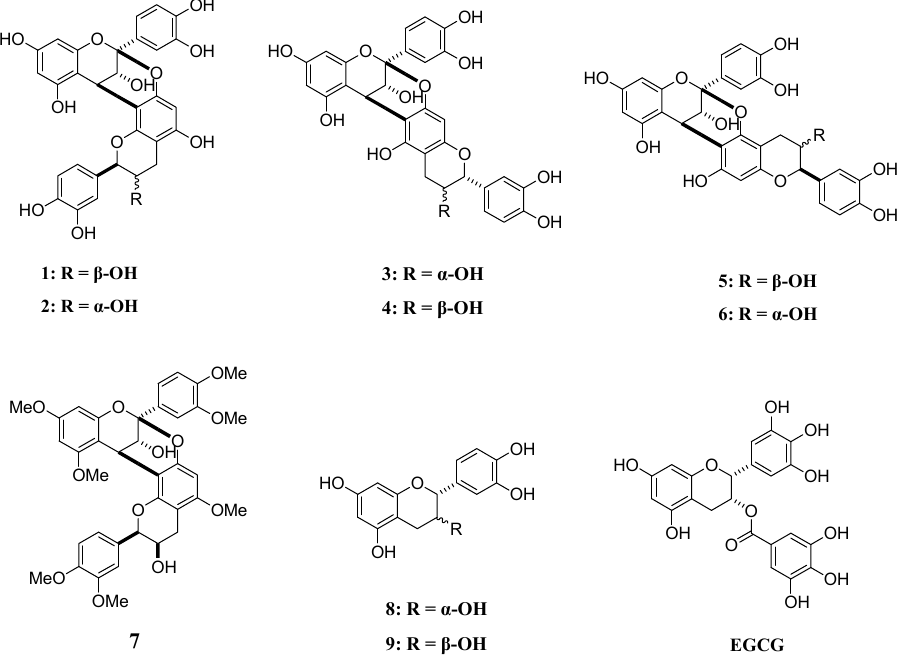
Figure 1. Structural formulae of compounds 1–9 and